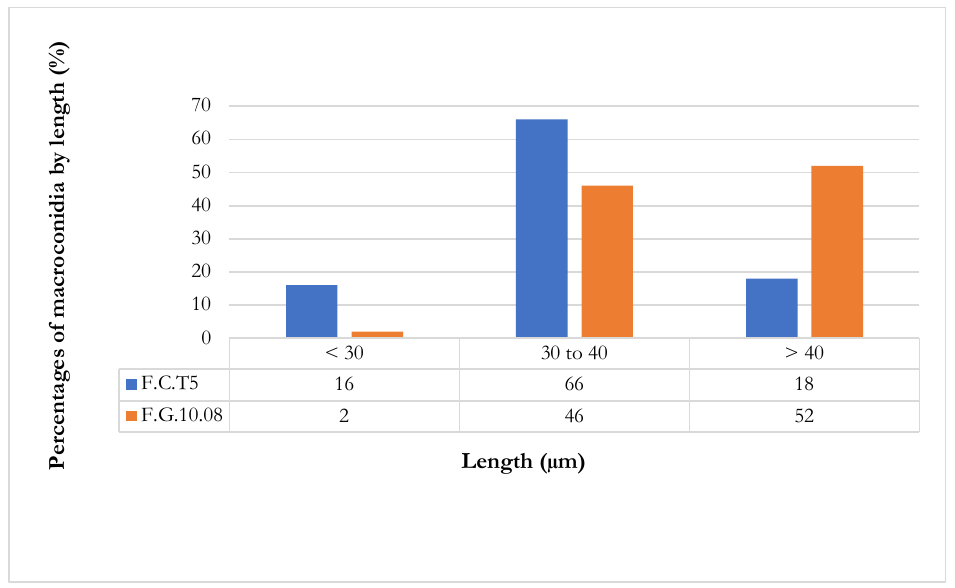
Figure 6. Percentage of macroconidia from each isolate by length